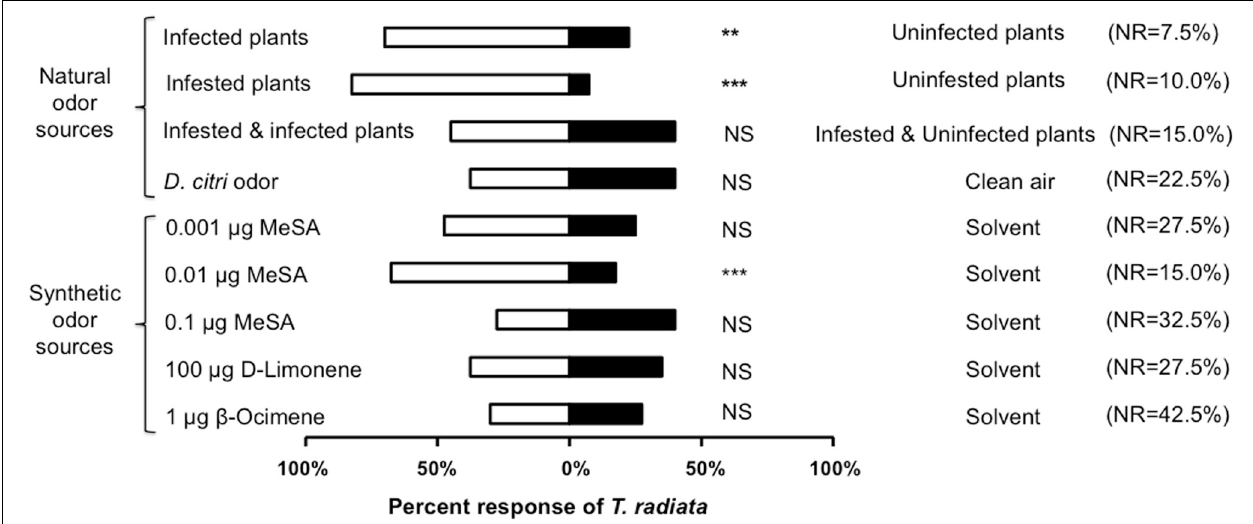
FIGURE 2 | Percentage of Tamarixia radiata responding to natural or synthetic odorants vs. blank or solvent negative controls, respectively, within a Y-tube olfactometer. NR: Percent of non-responders, n = 40. Asterisks indicate significant differences between the two treatments ( ∗∗ P < 0 . 01, ∗∗∗ P < 0 . 001).